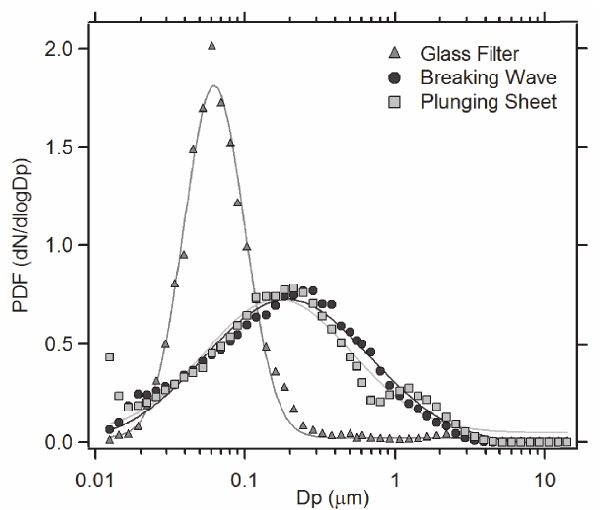
Fig. 5. Probability density functions of Sea Spray Aerosol (SSA) number distributions generated by the plunging sheet, breaking waves in a laboratory flume and sintered glass filters. The SSA par- ticle diameter was measured at 15 ± 10% relative humidity.